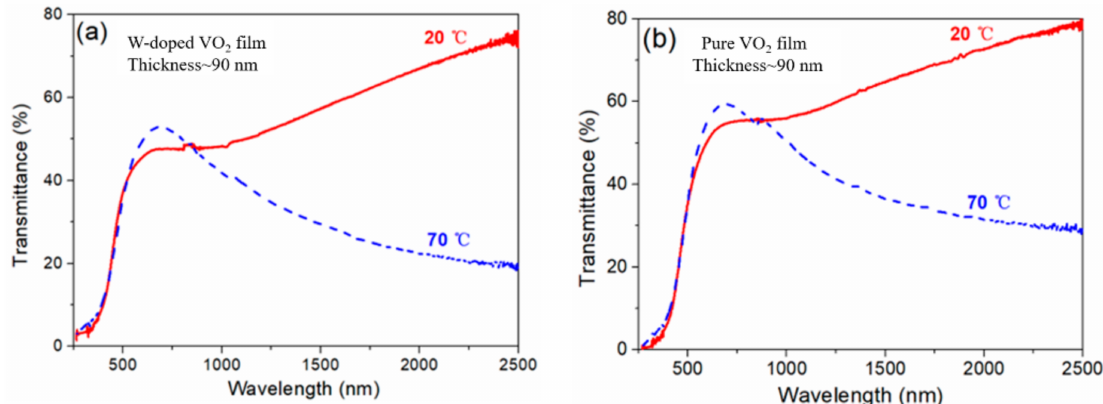
Figure 8. Transmission spectra of the ( a ) W-doped and ( b ) pure VO 2 films before and after their phase transitions.